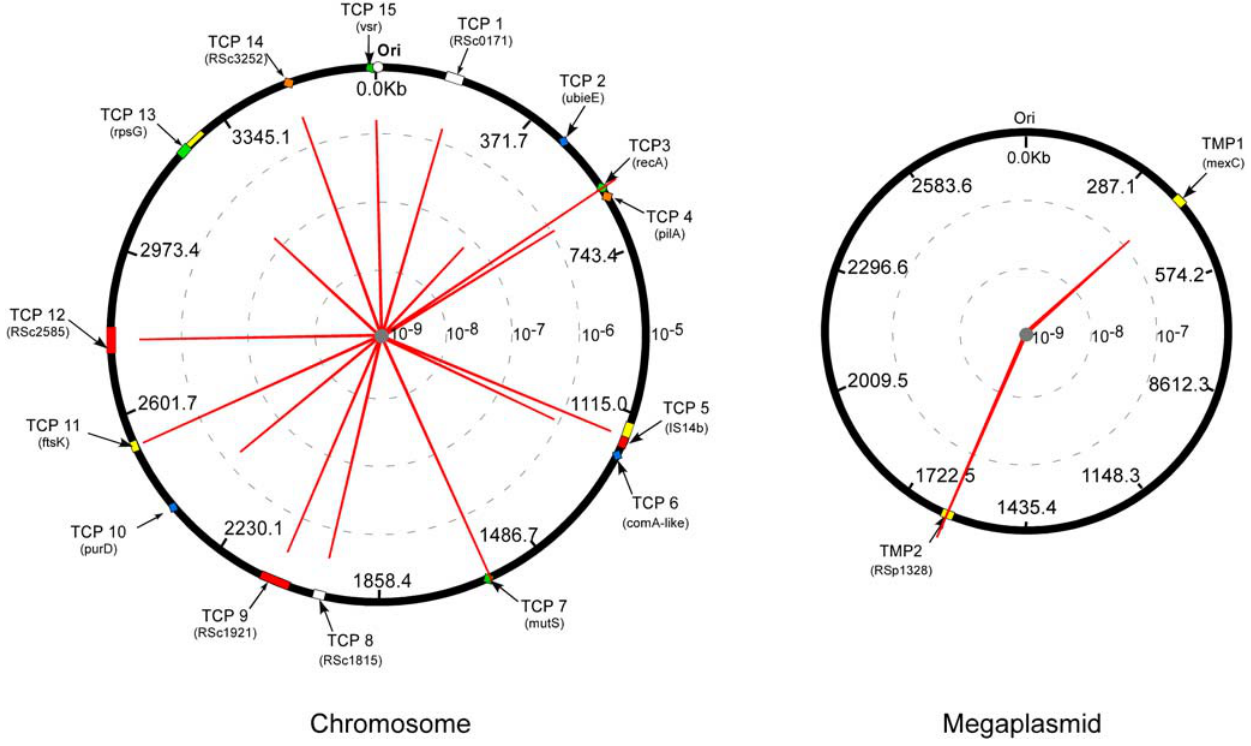
Figure 3. Recombination frequency variation between 17 R.solanacearumchromosome and megaplasmid borne DNA positions. Fifteen target positions on the chromosome (TCP) and three on the megaplasmid (TMP) were identified based on gene acquisition and function as described in the text. Plasmid donors were built following the general experimental design of figure 1. Recombination rate of these different genomic positions (proportional to red line) were measured after natural transformation and based on insertion of the aacC3-IV cassette by double crossing-over.